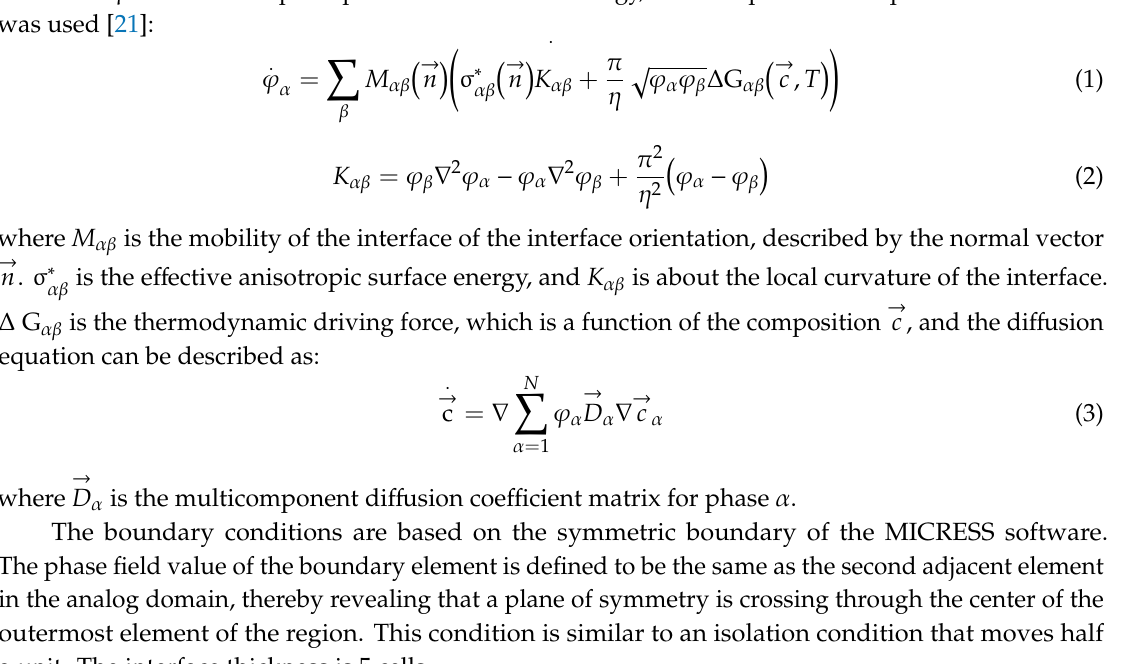
Table 1. Partial physical parameters [13,18,22].